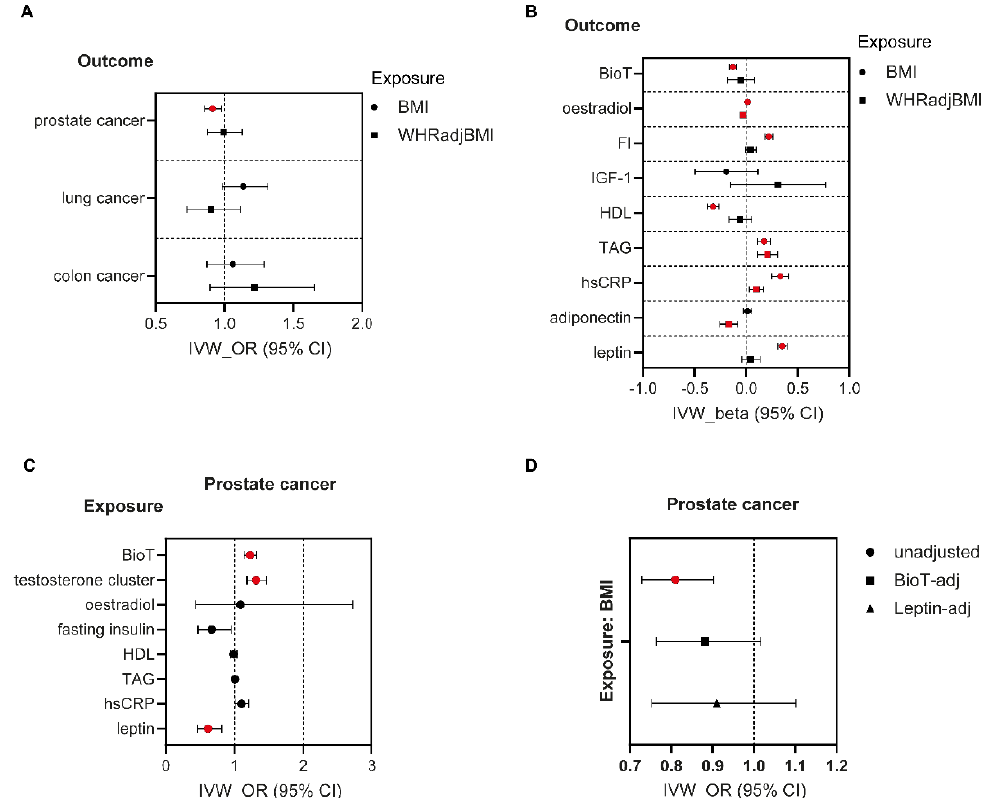
Figure 2. Two sample MR (IVW) estimates of effects of adiposity measures and traditional cancer drivers on cancer risk in men. ( A ) IVW estimates (OR, 95%CI) of the effects of BMI and WHRadjBMI on cancer risk in men. ( B ) IVW estimates (beta, 95%CI) of the effects of BMI and WHRadjBMI on potential cancer mediators in men. ( C ) IVW estimates (OR, 95%CI) of effects of mediators on risk of prostate cancer. ( D ) Mediation analysis: IVW estimates of effects of BMI on prostate cancer, adjusted for indicated cancer mediator. BMI-effect was not significant after adjustment for BioT or leptin. Red-filled symbols: Analyses yielding IVW results with p ≤ 0.008 (A), p ≤ 0.005 (B), and p ≤ 0.005 (C) (Bonferroni correction for multiple testing) and that are directionally consistent across all sensitivity analyses. BioT, bioavailable testosterone; FI, fasting insulin; IGF-1, insulin-like growth factor-1; HDL, high-density lipoprotein cholesterol; TAG, triglycerides; hsCRP, high-sensitivity C-reactive protein.